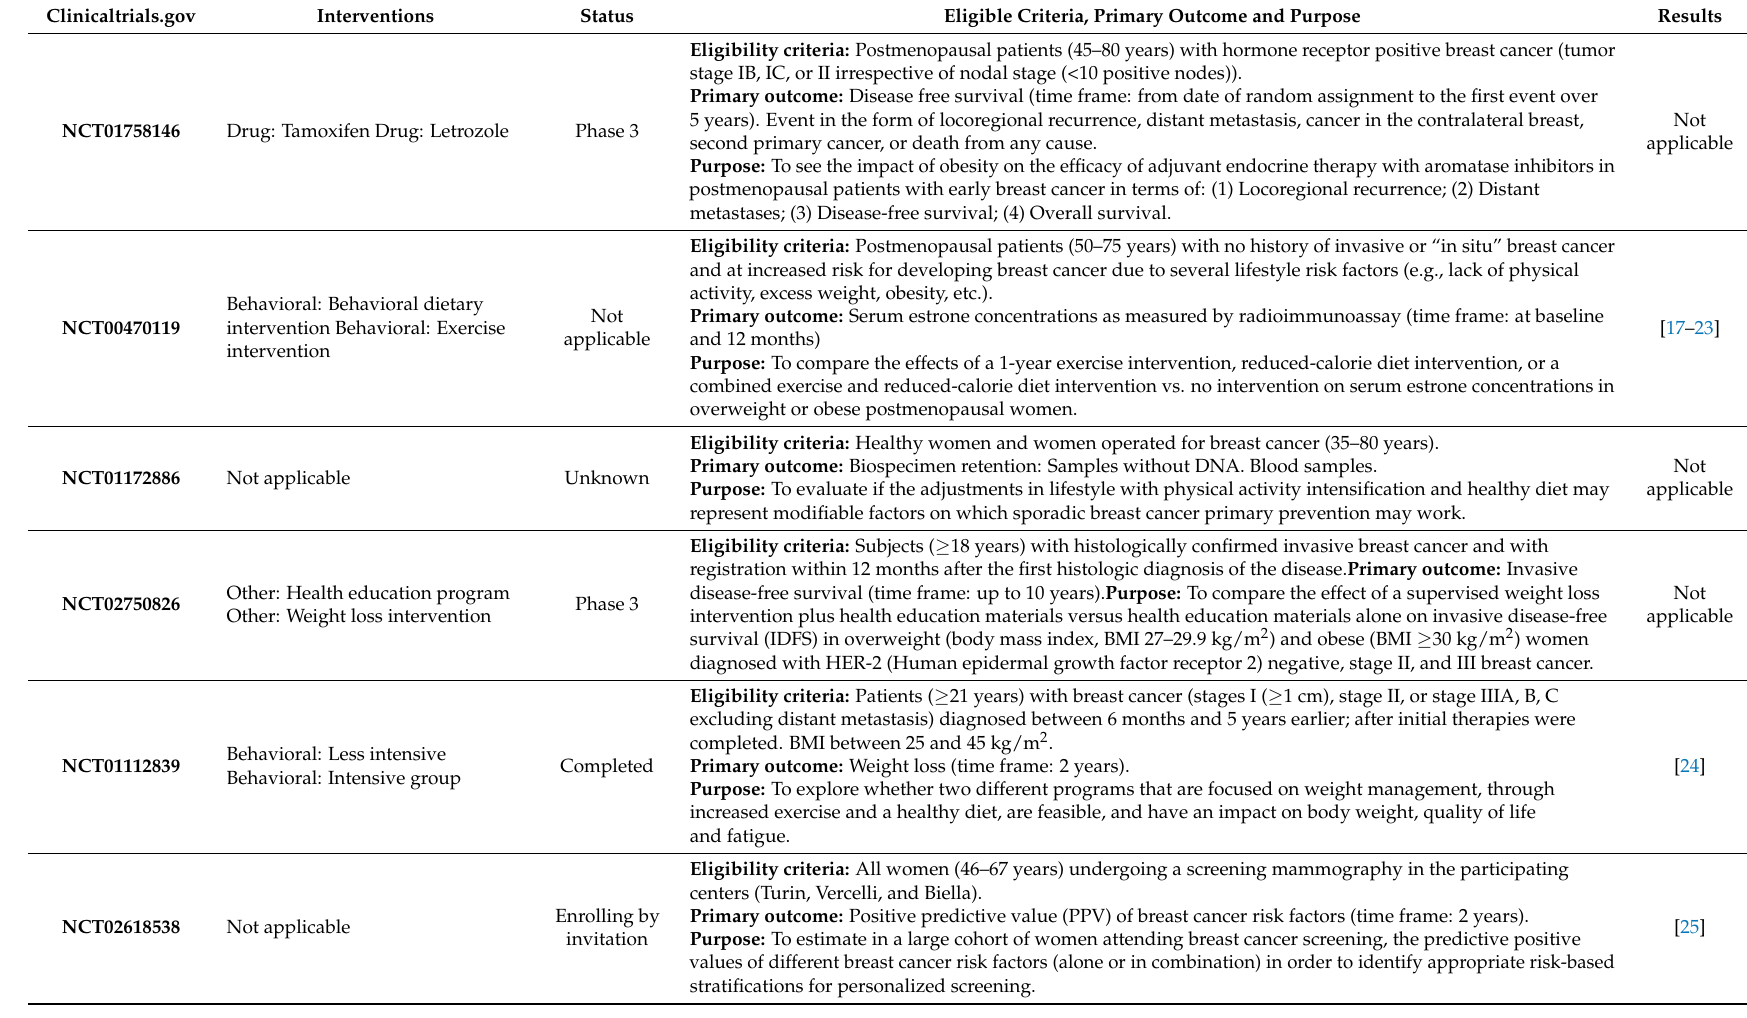
Table 1. List of the studies on obesity and breast cancer with ≥ 350 participants at